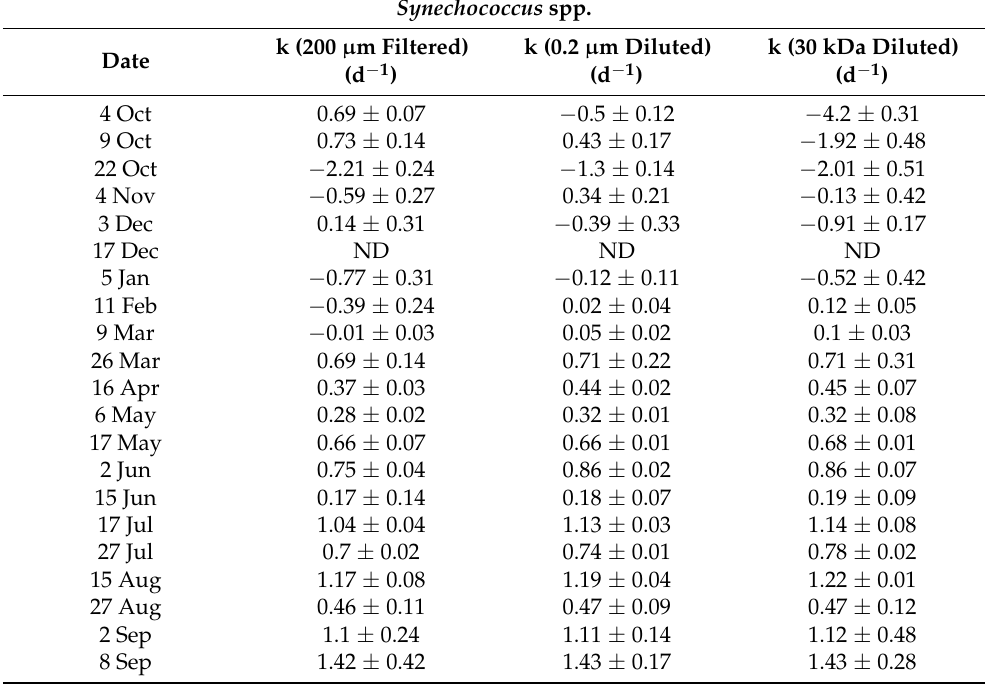
Table 1. Net growth rates of Synechococcus spp. in each treatment incubation: 200 µ m filtered water